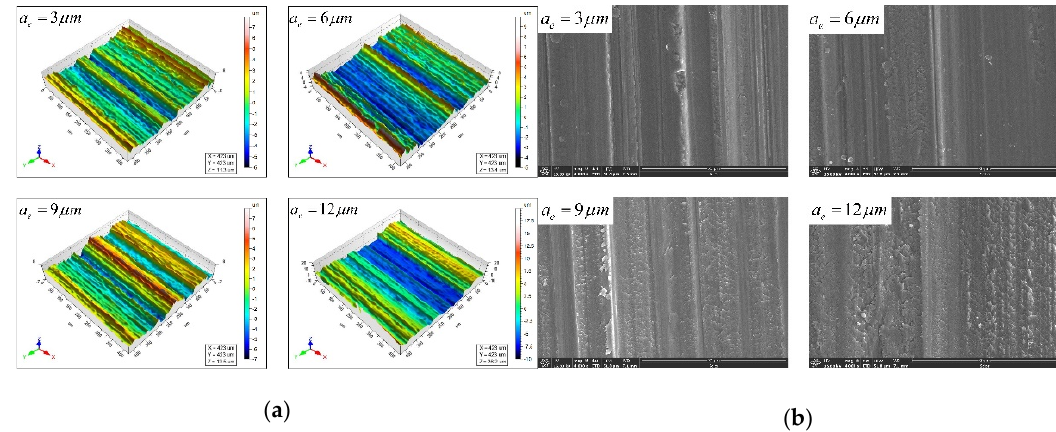
Figure 9. Comparison of three-dimensional surface microstructure under different grinding depths. (Feed rates: 200 mm/min, Grinding wheel linear speeds: 600 mm/min). ( a ) White light interferometer observation results. ( b ) Scanning electron microscope observation results.